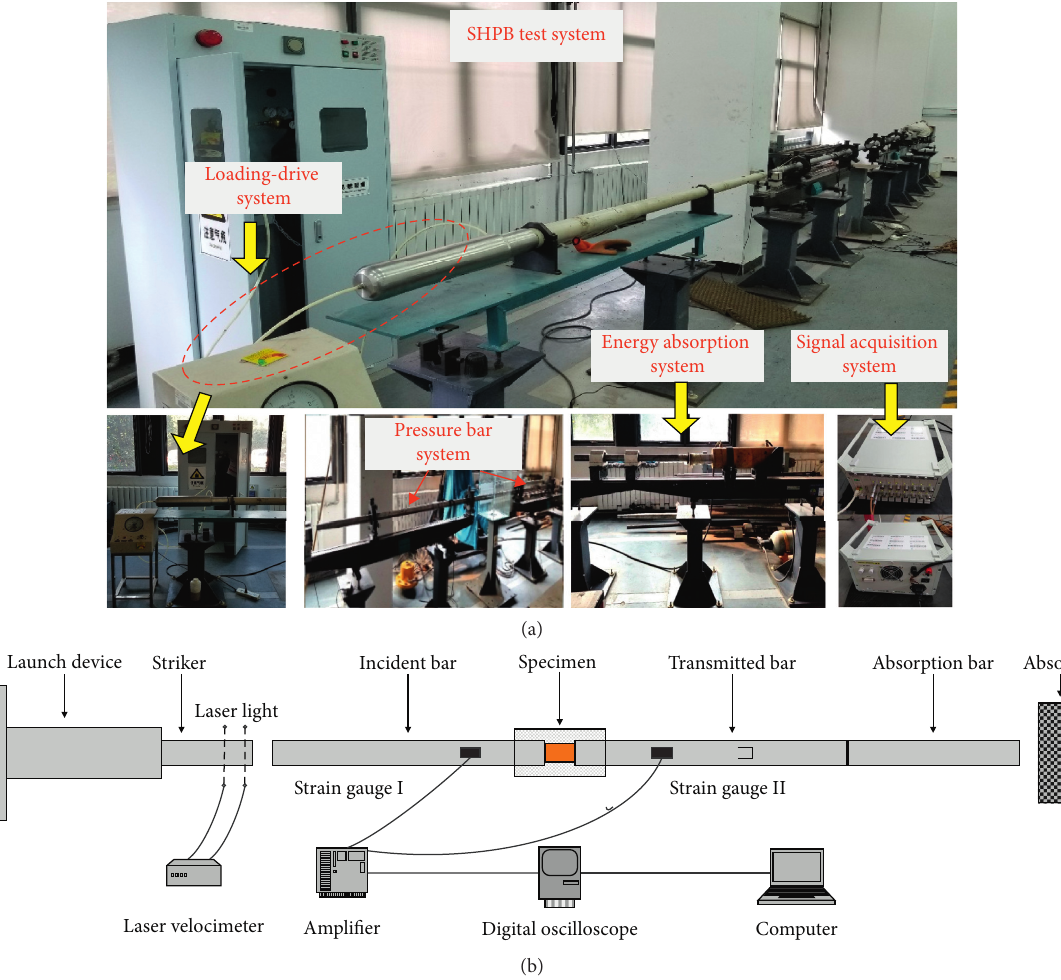
Figure 2: Illustration of the SHPB experimental system: (a) SHPB real products; (b) SHPB structural